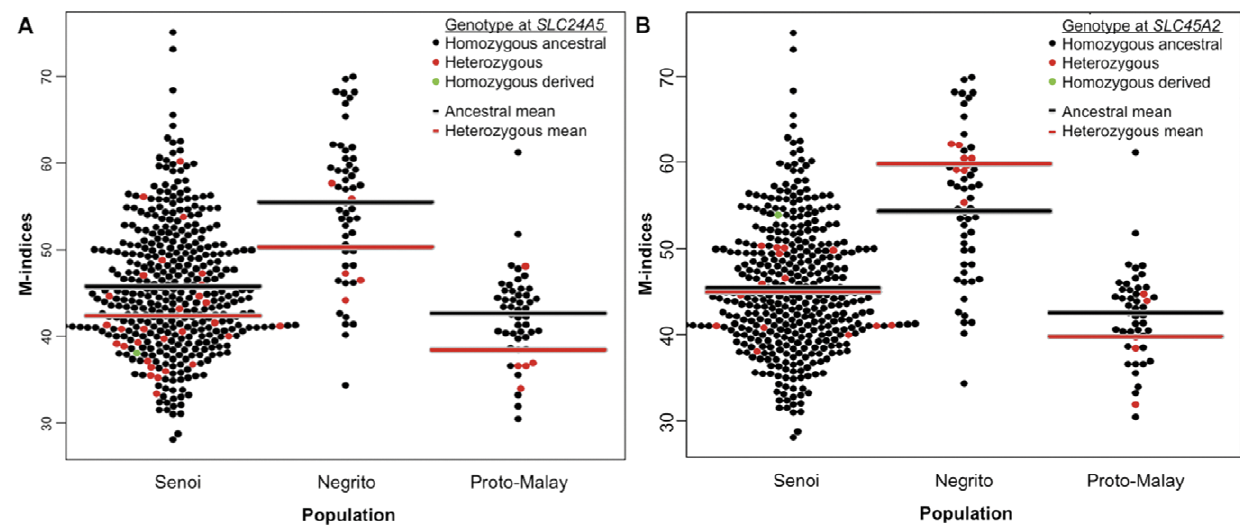
Figure 4. Beeswarm dotplot showing the effect of SLC24A5 A111T and SLC45A2 L374F on the Orang Asli skin color. A) SLC24A5 A111T showed a statistically significant effect on skin color ( p =0.0013) B) SLC45A2 L374F does not reach significance effect for the Orang Asli skin color ( p =0.37). The black line indicates the average M-index of samples with homozygous ancestral alleles, and the red line indicates the average M-index of samples with heterozygous derived alleles.